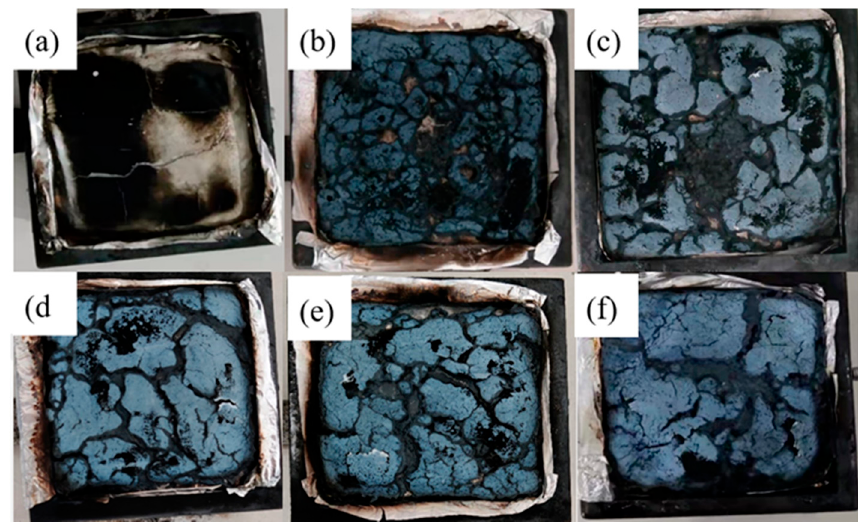
Figure 13. Digital photos of the charred residue samples collected after cone calorimeter tests. ( a ) EVA0; ( b ) EVA1; ( c ) EVA2; ( d ) EVA3; ( e ) EVA4; ( f ) EVA5.